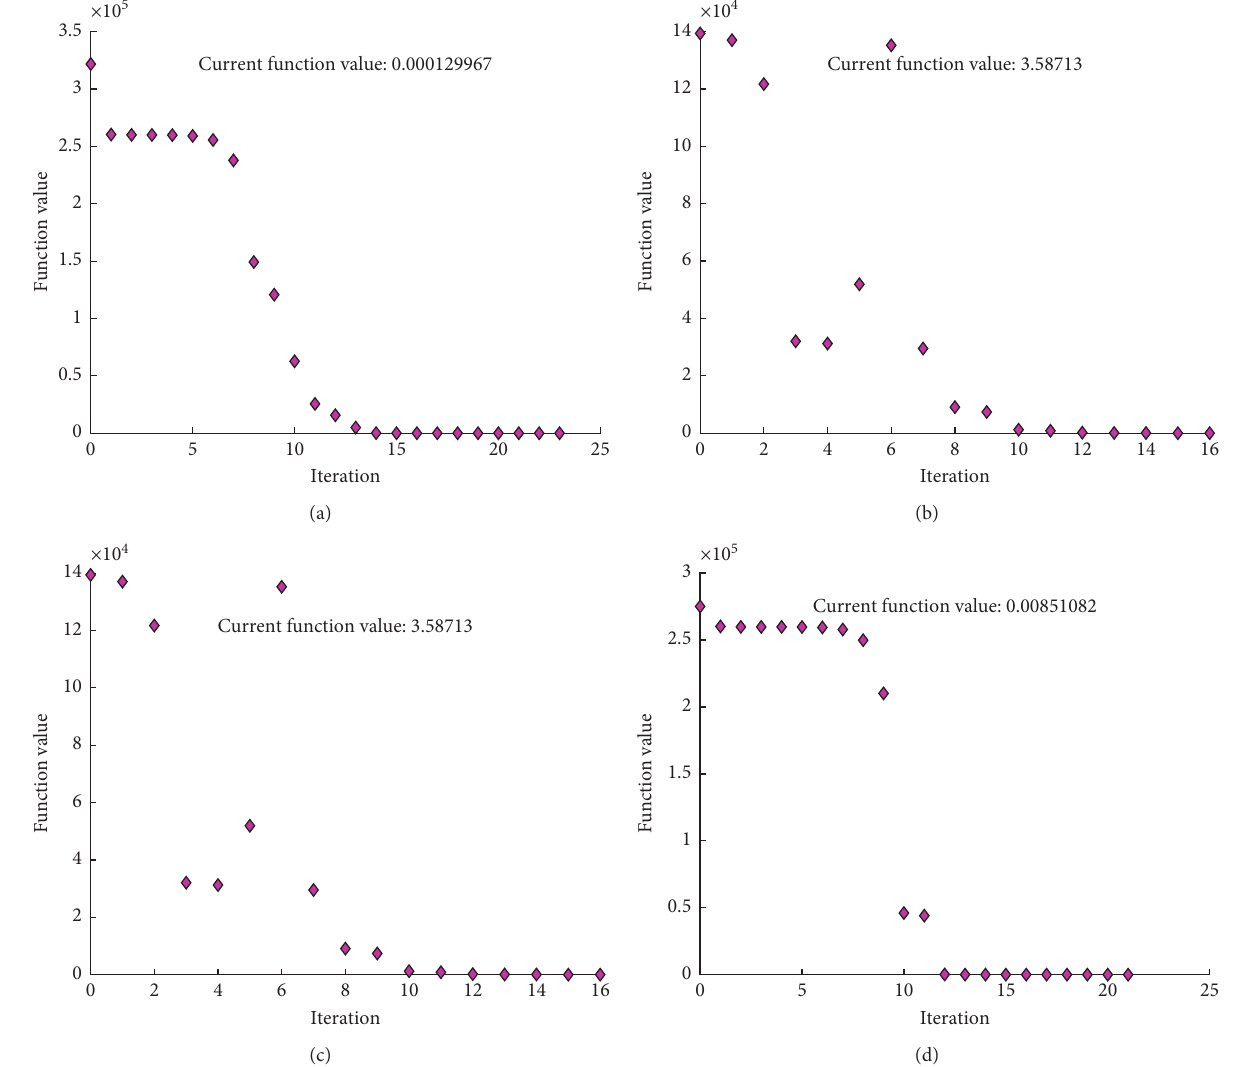
Figure 8: Iterative graph of algorithm for 4 nodes. (a) X 1 node algorithm iteration, (b) X 2 node algorithm iteration, (c) X 3 node algorithm iteration, and (d) X 4 node algorithm